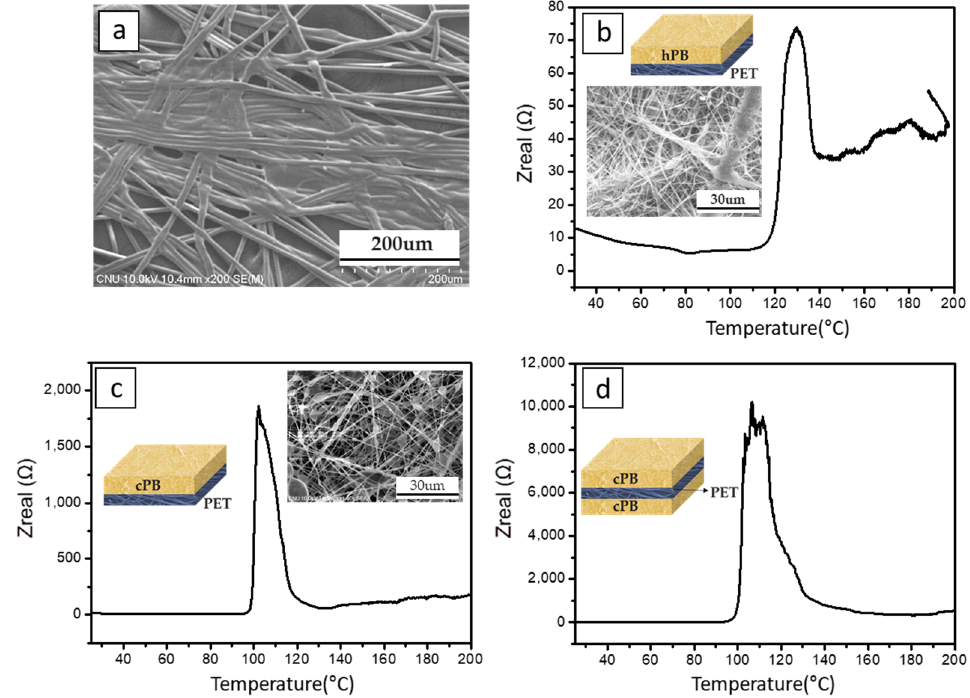
Figure 4. SEM image of ( a ) PET support and Shutdown test data of hPB and cPB fibrous membranes: ( b ) hPB on one side, ( c ) cPB on one side and ( d ) cPB on both sides.